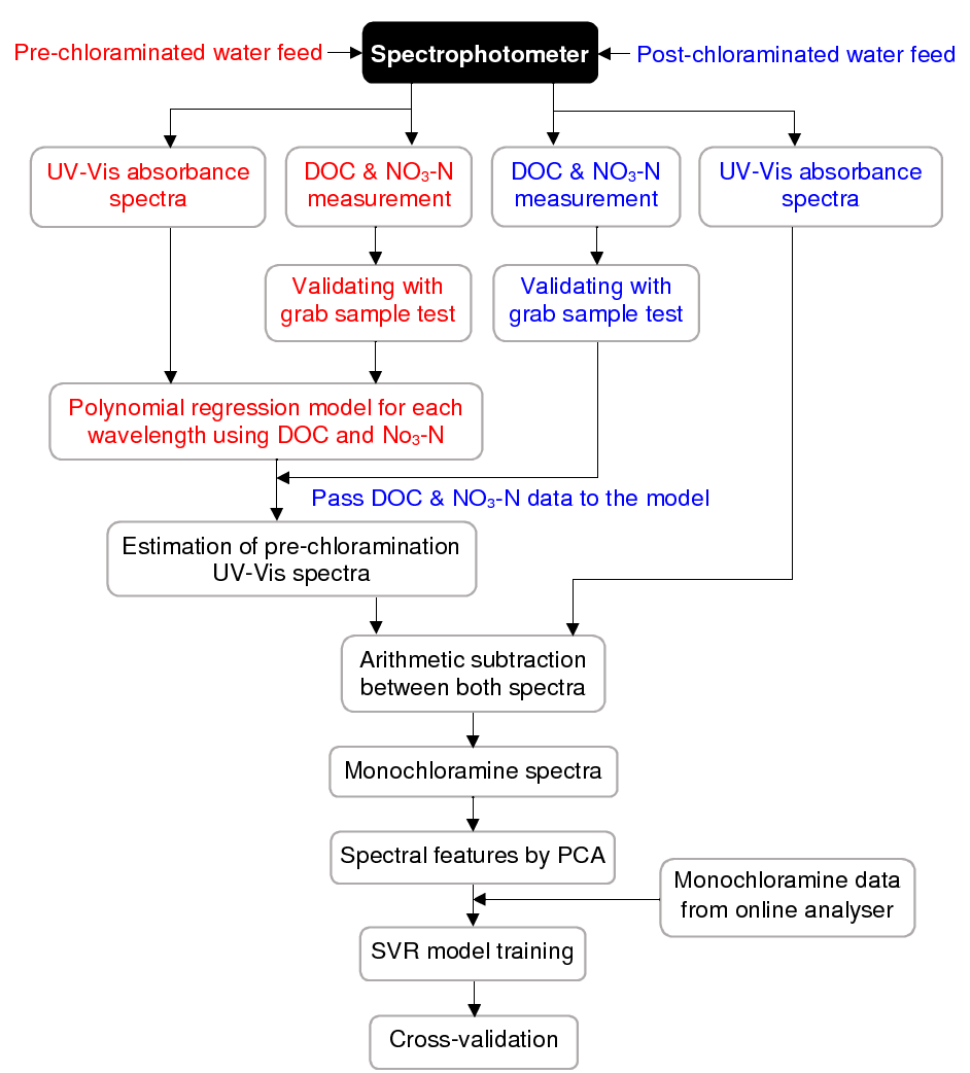
Figure 6. Procedure for separating monochloramine spectra (red colour refers to the process related to pre-chloraminated water and blue colour for post-chloraminated water).